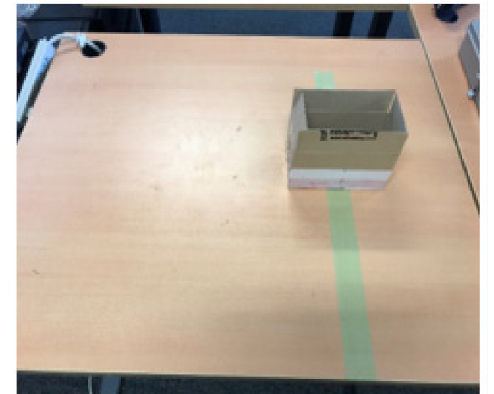
Figure 8. Example of a driving environment in the